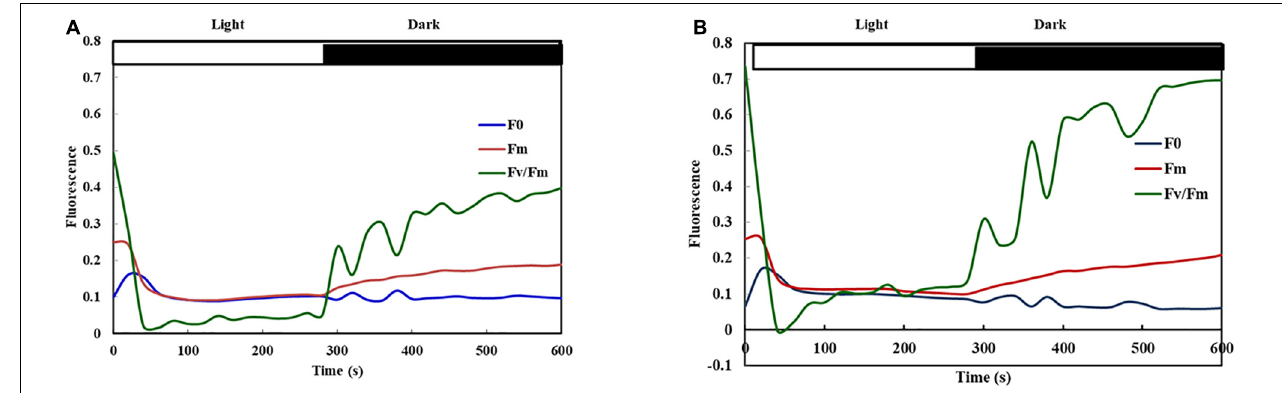
FIGURE 6 | Fluorescence kinetics of heat sensitive (PKGU-1; A ) and heat tolerant (UPU 85-86; B ) urdbean genotypes during light to dark transition. The dark phase started from 350 s. TABLE 12 | Half quenching time of Fm for heat tolerant (UPU85-86) and sensitive (PKGU-1) urdbean genotypes. Dark phase starting point (s) Half quenching time of Fm of heat tolerant Half quenching time of Fm of heat sensitive genotype UPU 85-86 (s) genotype PKGU -1 (s)